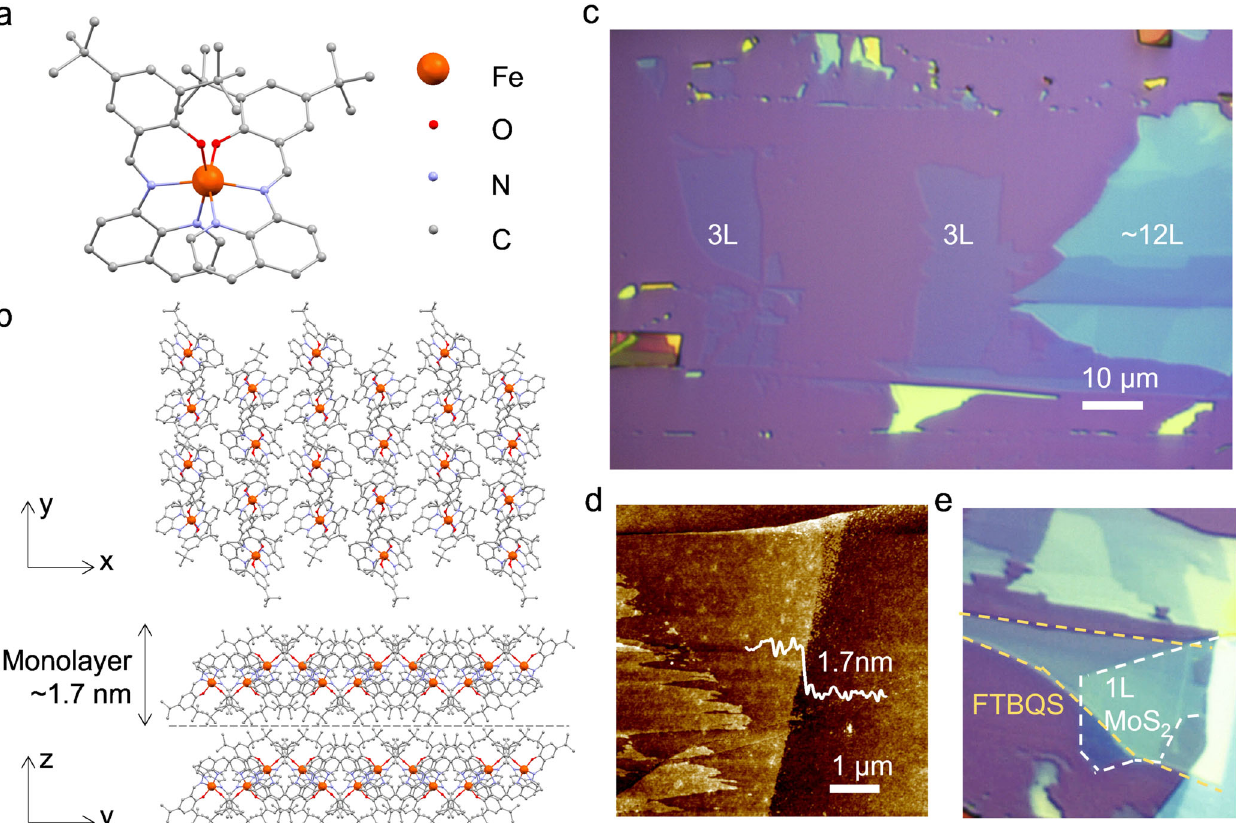
Fig. 1 Molecular structure and identi fi cation of exfoliated [Fe( t Bu 2 qsal) 2 ] layers. a The crystal structure of [ Fe( t Bu 2 qsal) 2 ] (FTBQS) molecule complex. The H atoms are omitted for clarity. b The single-crystalline structure of FTBQS. The x-y plane corresponds to the (100) plane of the crystal. The z -direction corresponds to the out-of-plane direction, and the unit cell thickness is measured to be ~1.7 nm. The color code follows the notations in a . c The white light microscope picture of single-crystalline FTBQS fl akes of different layer numbers. The layer number is assigned from the AFM data. d The atomic force microscope (AFM) image of the monolayer FTBQS region on SiO 2 /Si substrate. The height pro fi le, which shows a 1.7 nm monolayer step, is shown. e The microscope image of the assembled heterostructure assembled through dry transfer technique. The yellow and white dashed lines outline the crystal edges of ~10 L FTBQS and a monolayer MoS 2